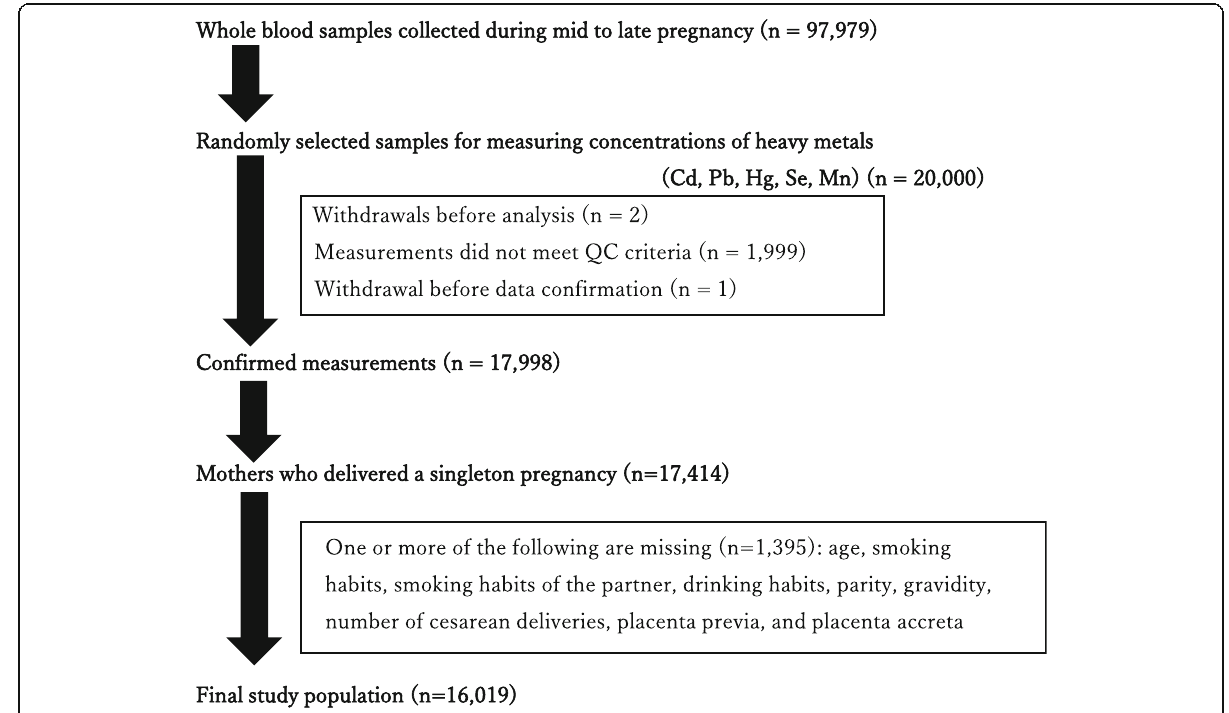
Fig. 1 Flow chart of the study subjects. Of the samples collected from the 97,979 women during mid to late pregnancy, 20,000 whole blood samples were randomly selected. To measure metal concentrations, 17,998 blood samples of women who met the QC criteria were used. Of these 17,998, 17,414 who delivered singleton pregnancies were selected. After excluding women with missing data ( N = 1395), the final study population comprised of 16,019 women. Cd, cadmium; Pb, lead; Hg, mercury; Se, selenium; Mn, manganese; QC, quality